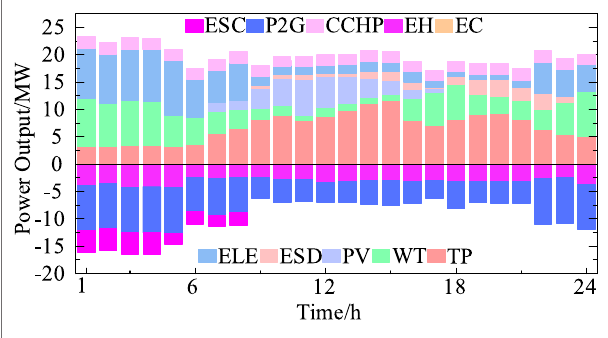
FIGURE 6 | Operation of each unit in case 2.